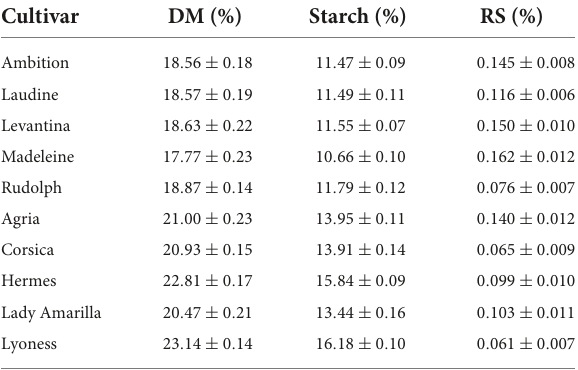
TABLE 3 Evaluation of frying as crisps at 176 ± 5 ◦ C.